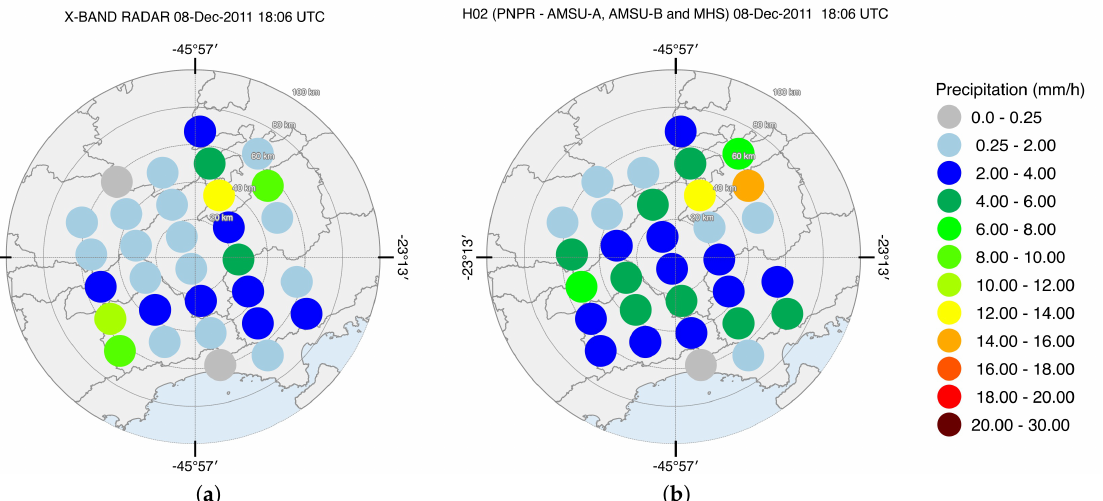
Figure 19. ( a ) Rain rate from radar upscaled to the satellite grid and ( b ) H02 rain rate map in Vale do Paraíba on 8 December 2011 at 18:06